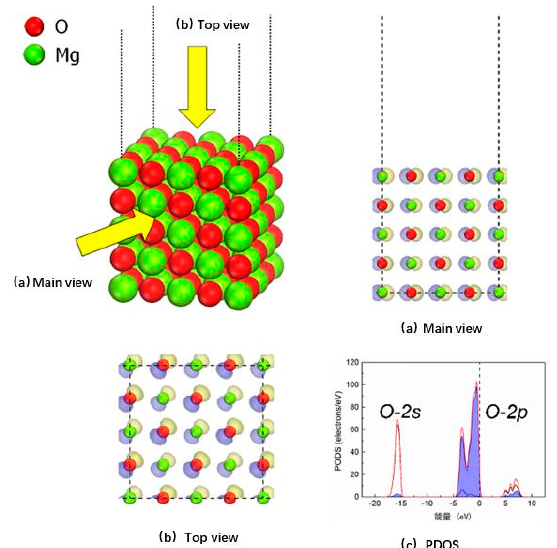
Figure 2. Surface model and state density analysis of MgO